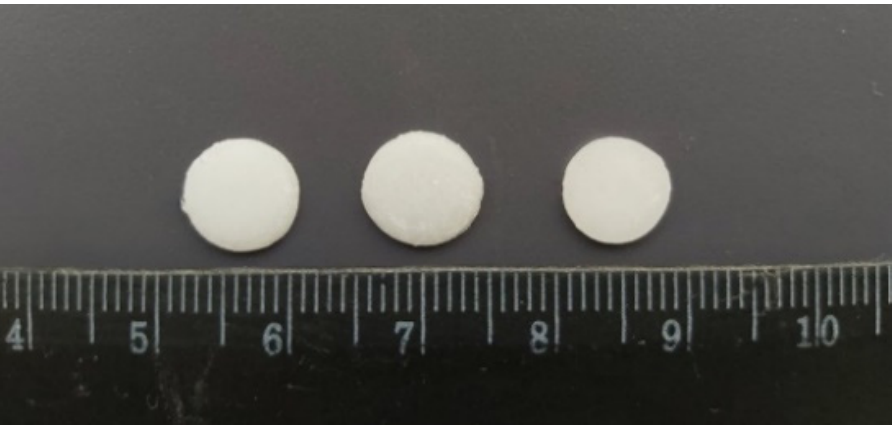
Figure 2. Fabricated tablets containing 15% ATH (atomoxetine hydrochloride) with diameters of 8 mm and 2 mm thickness.